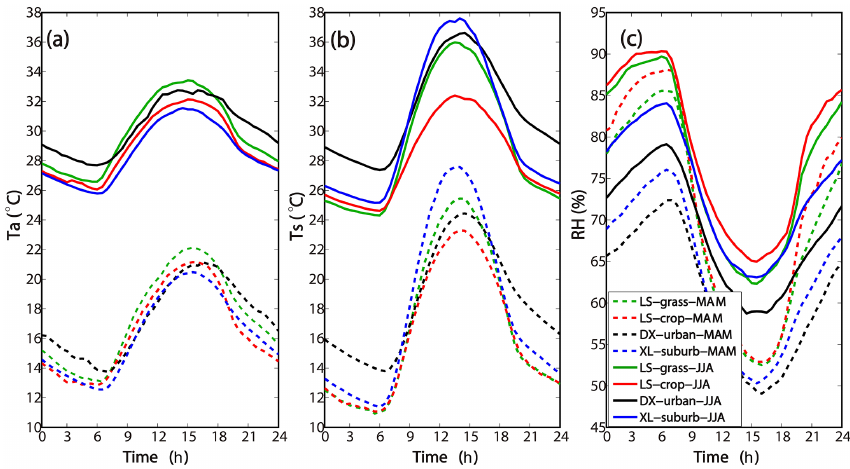
Figure 3. Diurnal variations in (a) air temperature, (b) surface temperature, and (c) relative humidity at the four sites in Nanjing in the spring and summer.